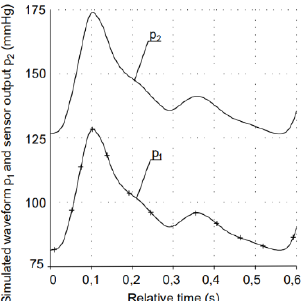
Fig. 2. Comparison of pressure inside the artery imitation (p 1 ) and device’s readings (p 2 ), x – pressure calculated based on static characteristic.